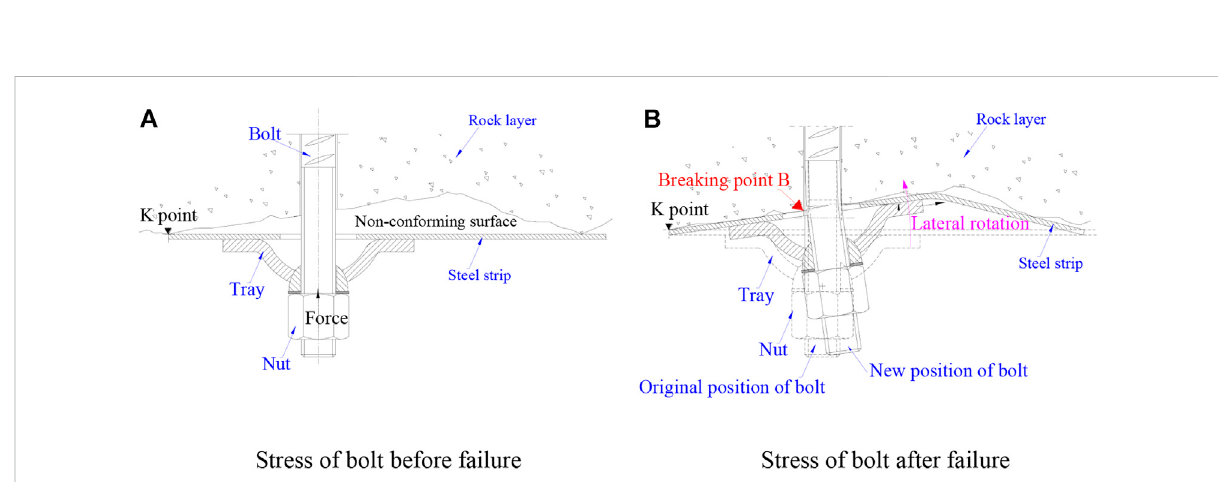
FIGURE 5 Force analysis of breaking bolts. (A) Stress of bolt before failure. (B) Stress of bolt after failure.